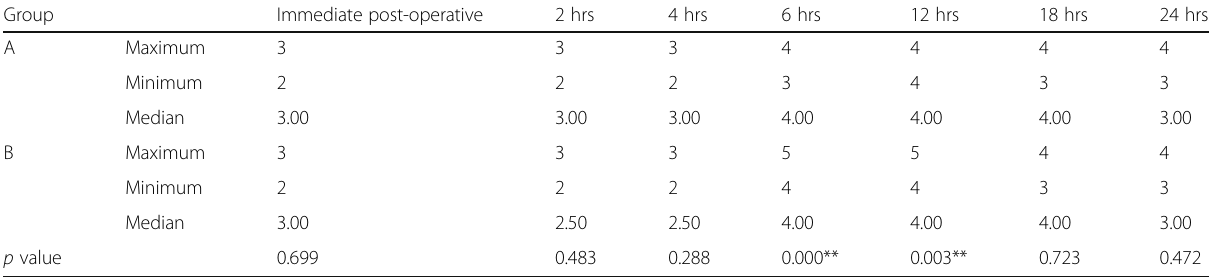
Table 4 Visual analog scores